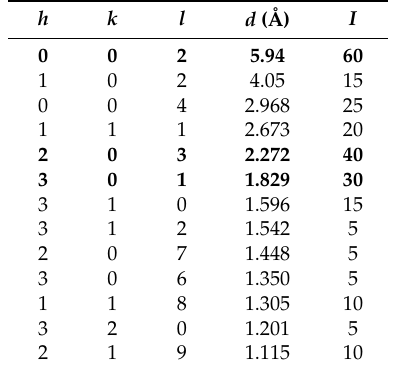
Table 4. X-ray diffraction data (using Cu K α ) belonging to the H -subcell of merelaniite. The three most intense reflections are indicated in boldface type.